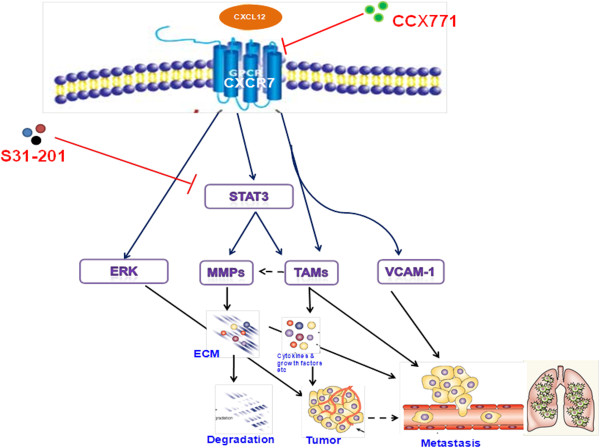
Schematic representation of CXCR7-mediated signaling that regulates breast cancer growth and metastasis. CXCL12 binding to CXCR7 leads to activation of ERK and STAT3 and enhanced expression of VCAM-1. CXCR7 also, either directly or indirectly through STAT3, may enhance MMP-9 and TAMs recruitment to the tumor site. TAMs in turn enhance growth factor, chemokines, and MMPs secretion in a tumor microenvironment. These CXCR7-mediated mechanisms may regulate primary breast tumor growth and metastasis, especially to lungs.